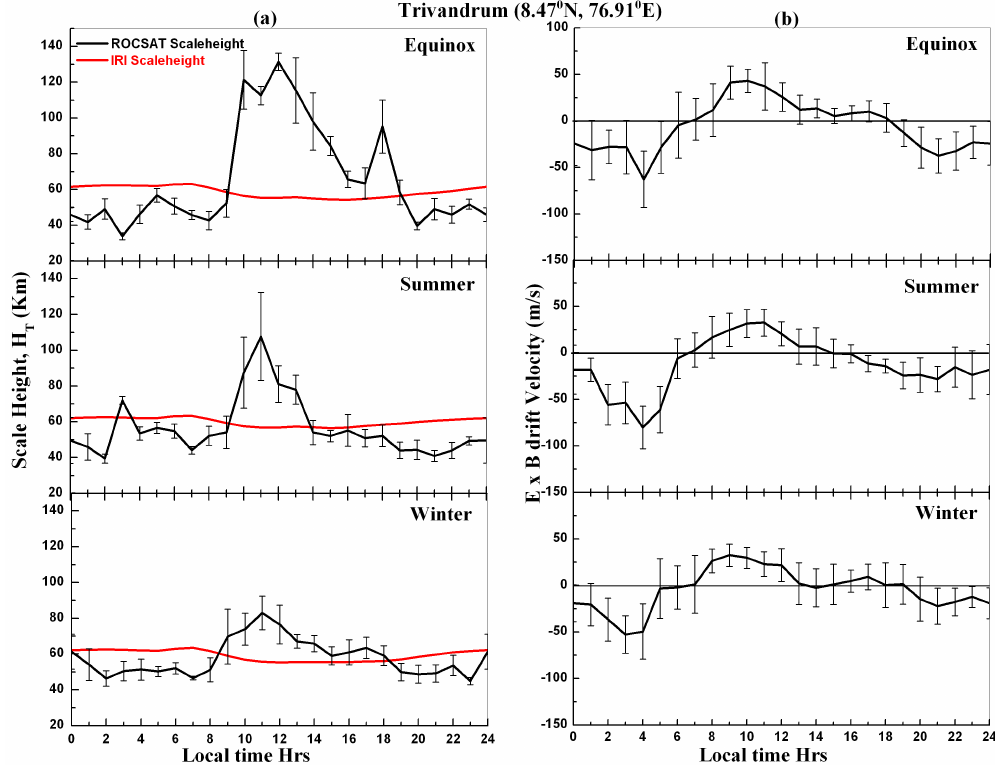
Fig. 8. The mean diurnal variations of effective scale height ( H T ) and E × B drift velocities (measured by ROCSAT-1 satellite and IRI model (red line)) over Trivandrum during three different